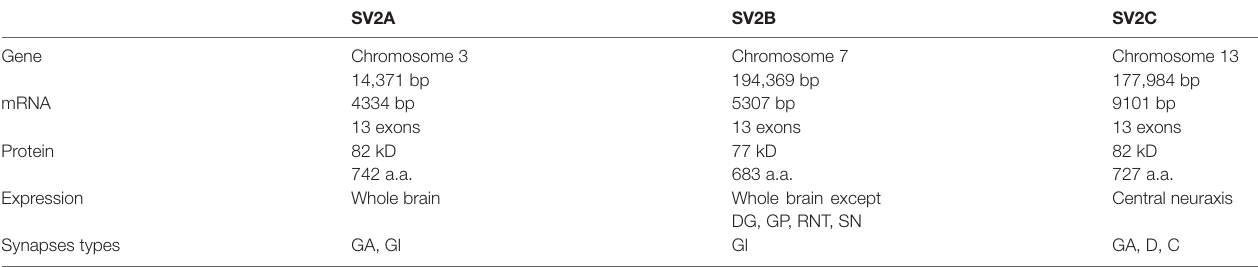
TABLE 1 | SV2 protein family information